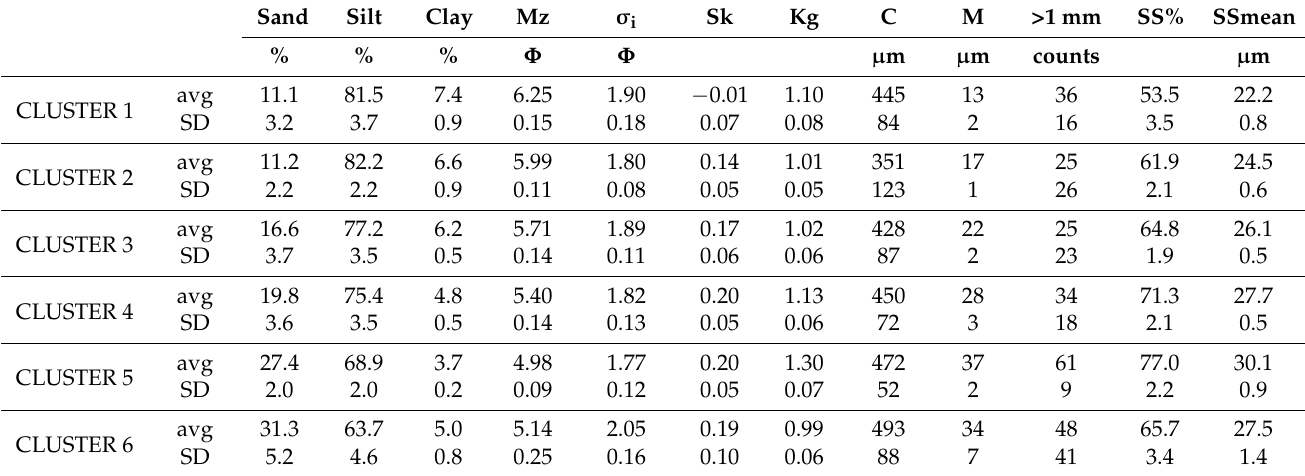
Table 3. Main grain size data and statistical parameters for each grain size cluster. Mz, σ i , Sk and Kg are the mean size, sorting, skewness and kurtosis according to [38], C is the 1st percentile, M is the median, SS is the sortable silt, calculated according to